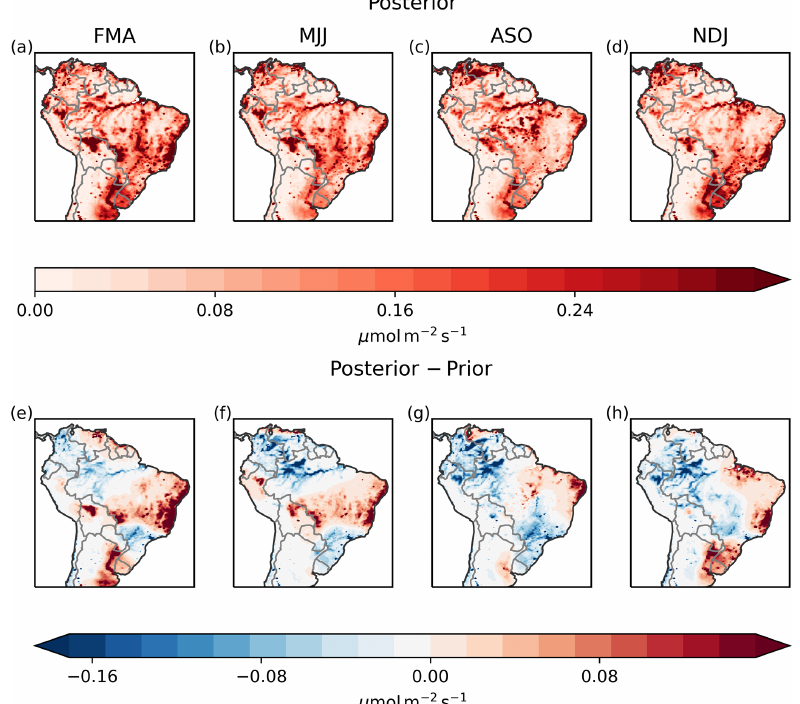
Figure A3. Emissions maps across the 2011–2018 time period grouped into February–April (FMA), May–July (MJJ), August–October (ASO) and November–January (NDJ). Panels (a) – (d) CH 4 posterior emissions maps and (e) – (h) difference between the posterior and the a priori emissions input.